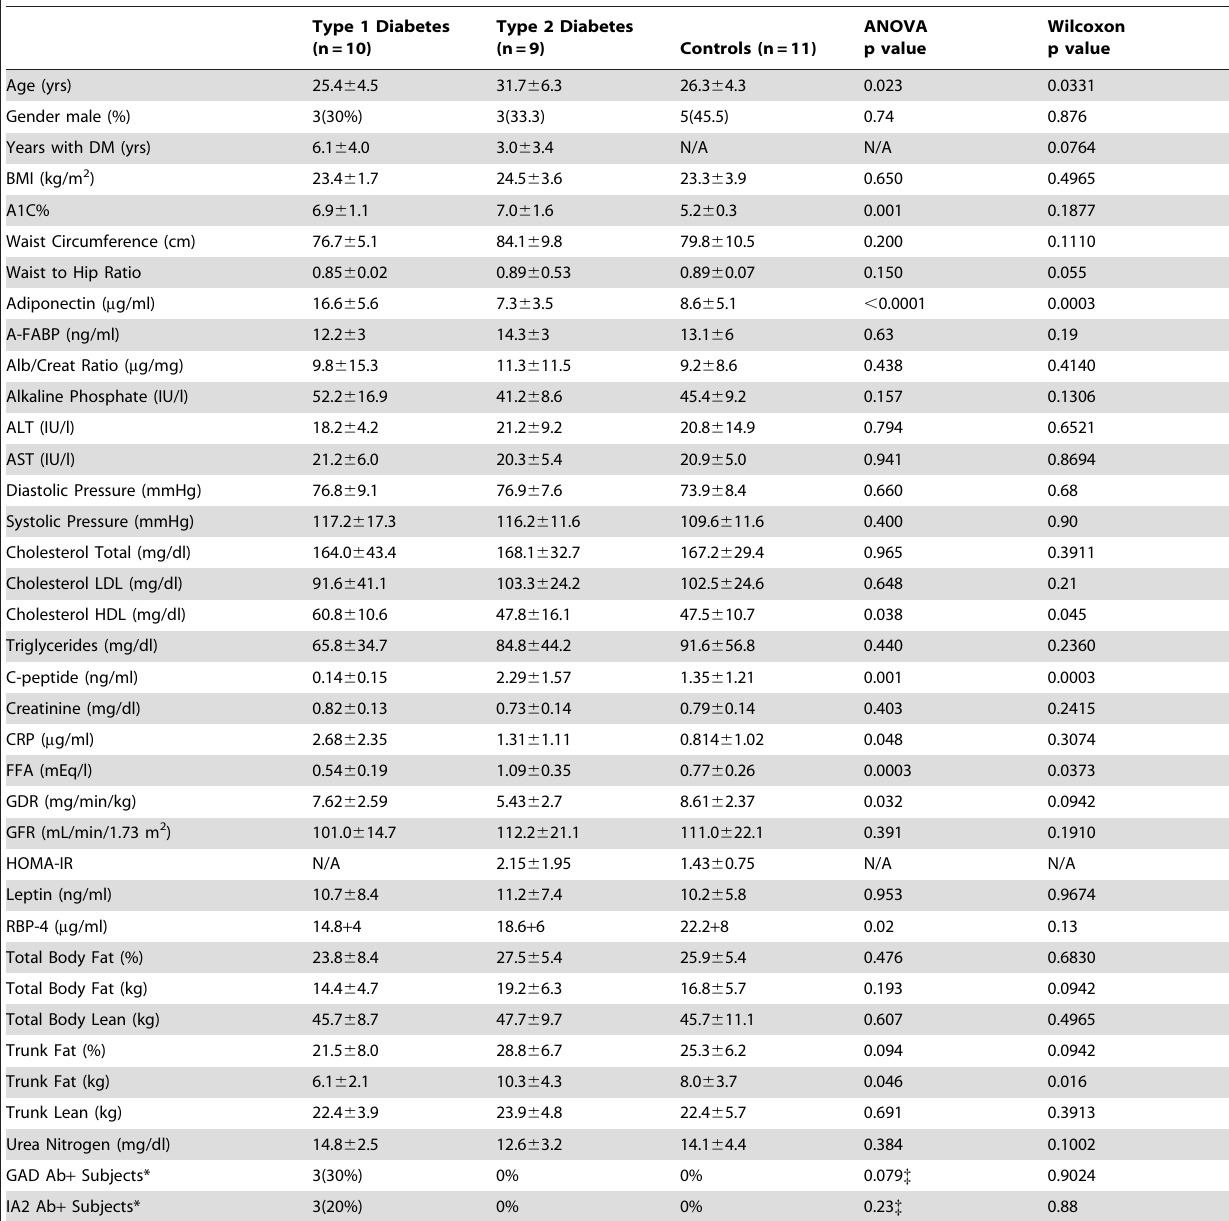
Table 1. Baseline characteristics, separated by